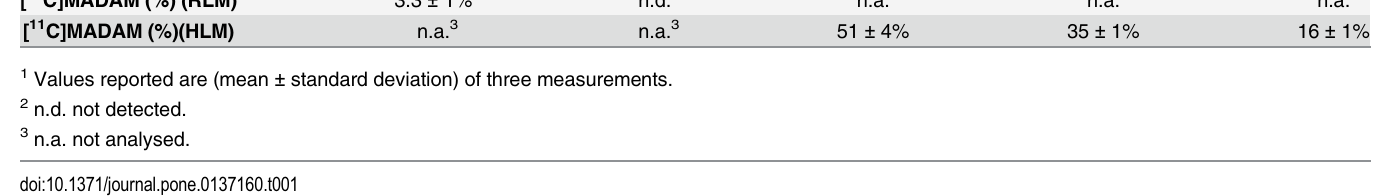
radiometabolism rate of the radioligand [ 11 C]MADAM were observed in RLM and HLM